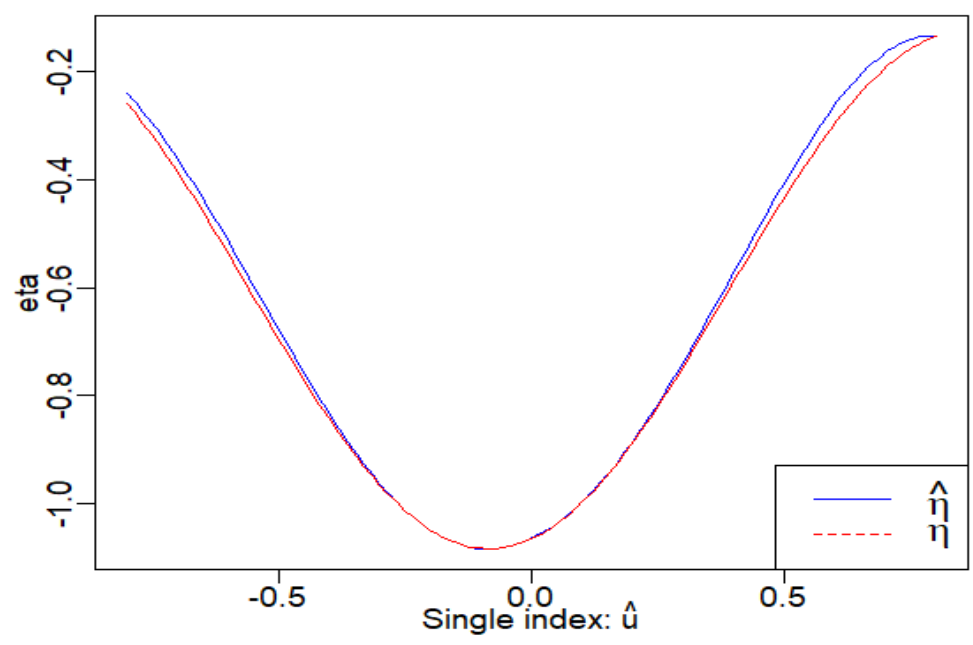
Figure 4. Estimated non-parametric function ˆ η ( . ) and non-parametric function η ( . )